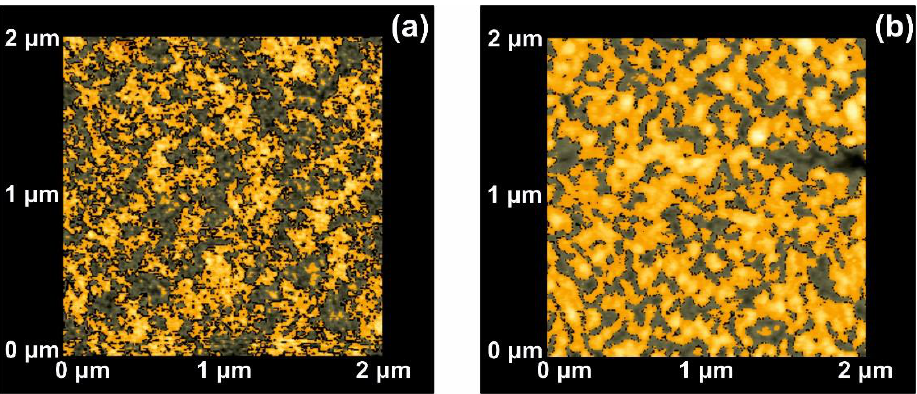
Figure 3. Atomic force microscopy (AFM) image of “lake” (grey) and “island” (orange) for a fractal area of 2 × 2 µ m 2 : ( a ) Non-irradiated area; ( b ) irradiated area with 10 3 laser pulses.